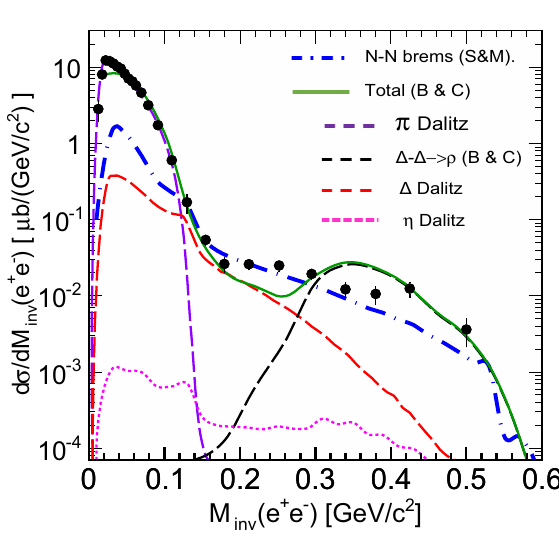
Figure 7. Invariant mass distribution of dielectrons measured in a quasi-free n + p collisions at E kin = 1 . 25 GeV compared to the N − N bremsstrahlung model of [29] (blue-dashed) and the model of [30] (green) decomposed in the Δ Dalitz (red dashed), ΔΔ fusion and π 0 Dalitz (dashed-violet) contributions.